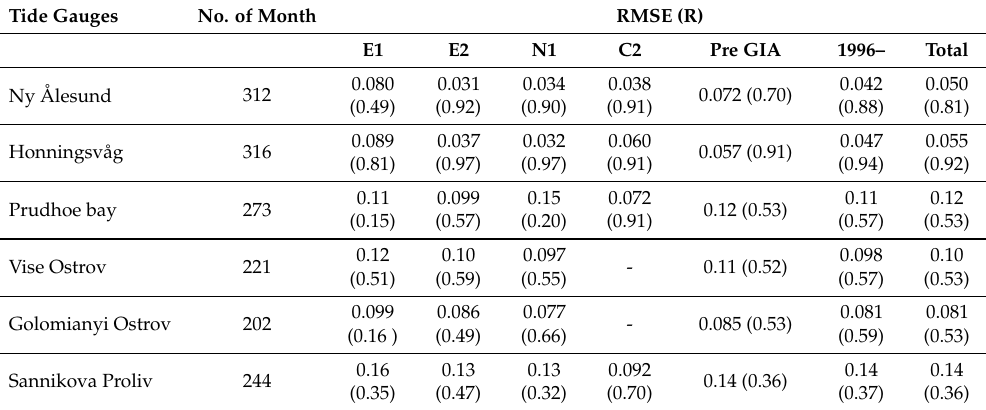
Table 5. Tide gauge comparisons. The second column shows the number of months